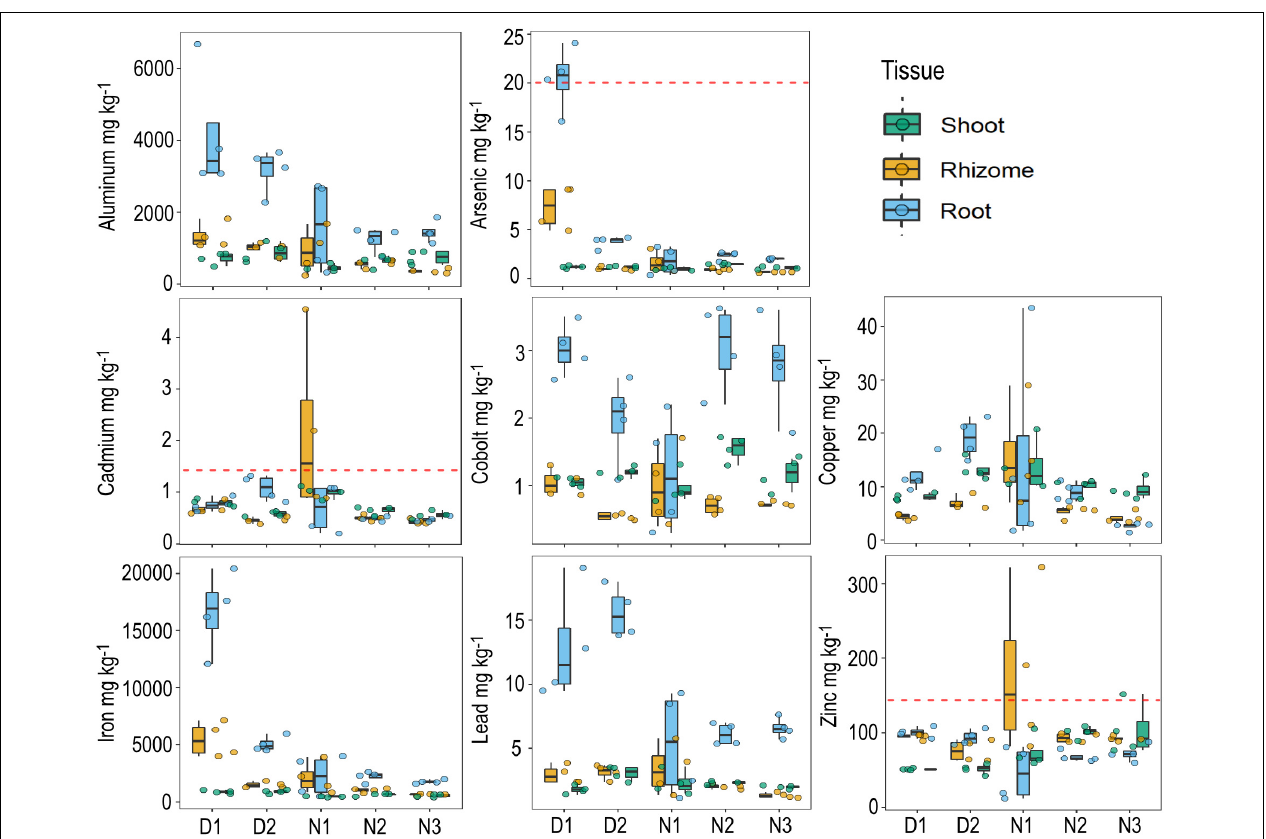
FIGURE 4 | Metal concentrations in seagrass tissue (shoot, rhizome, and roots) by site. Data are boxplots with datapoints overlain. The dashed red line indicates the default value guideline (the concentrations below which there is a low risk of unacceptable effects occurring) for toxicants in sediment according to the Australian and New Zealand Guidelines for Fresh and marine water